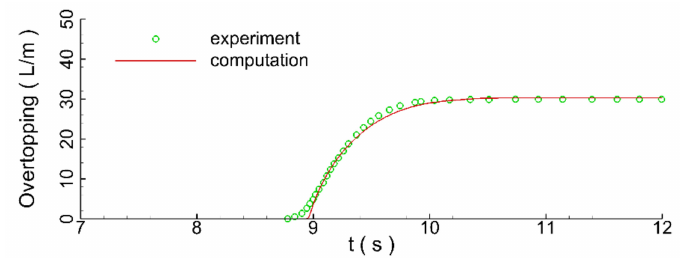
Figure 11. Comparison of the time series of overtopping water volume.